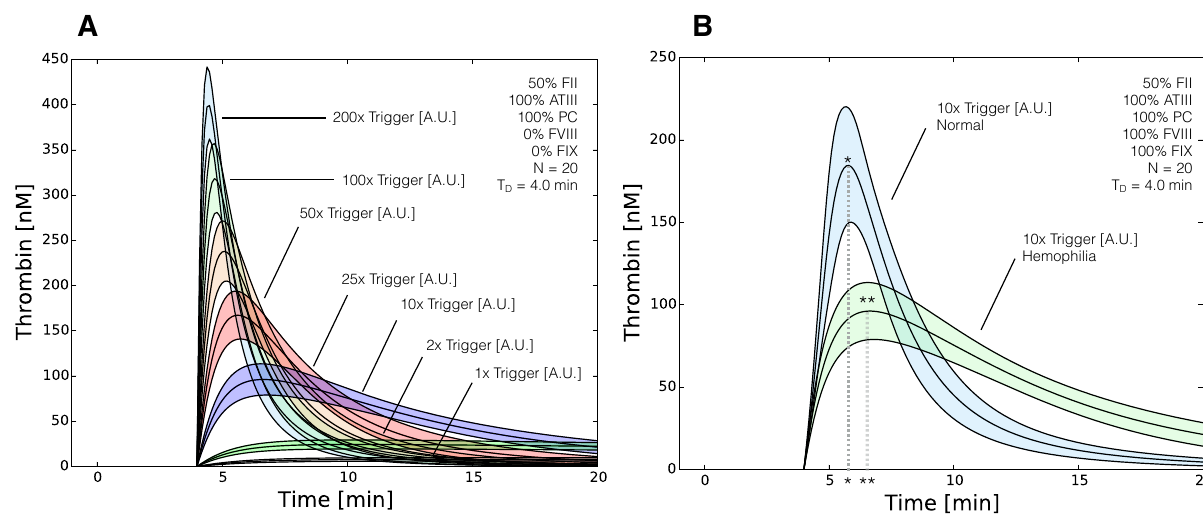
Figure 7. Reduced order coagulation model predictions of rFVIIa administration. ( A ) Simulations of thrombin formation in the presence of ATIII and the protein C